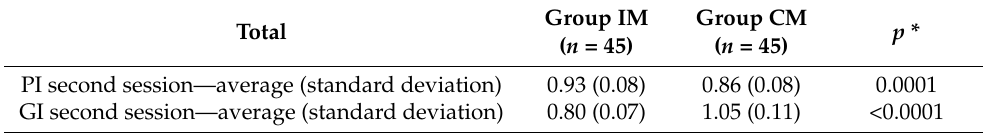
Table 9. Average (standard deviation) of PI and GI in the second monitoring session in all patients. Group Total